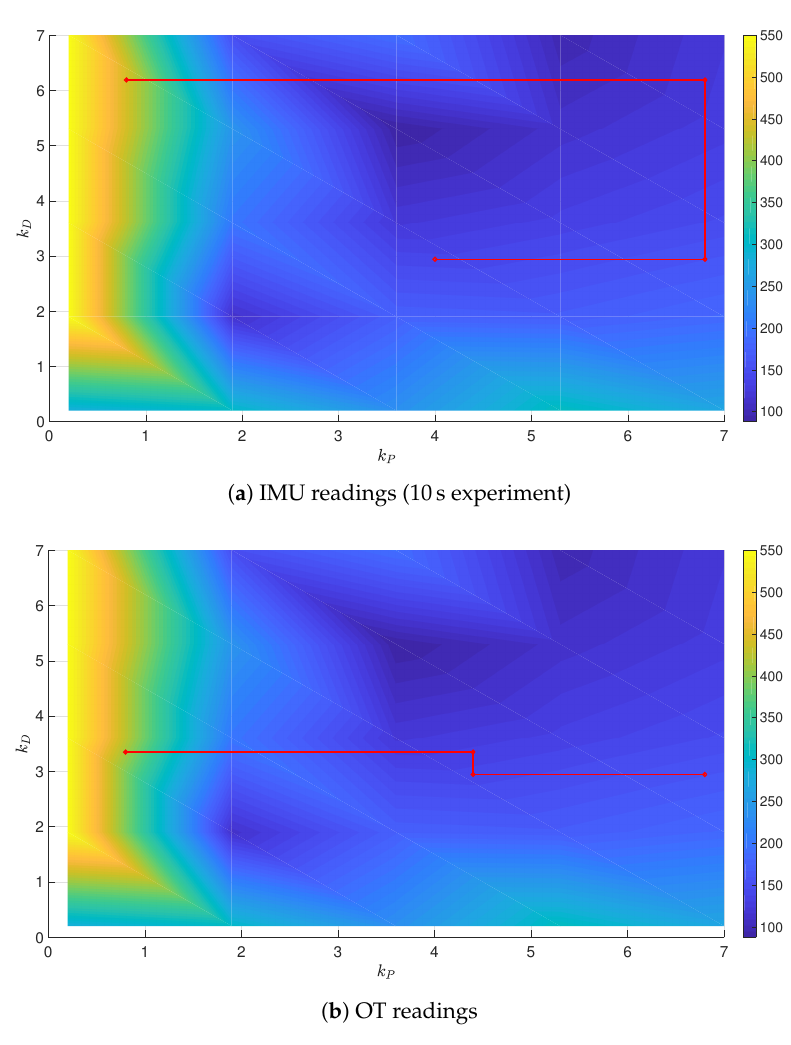
Figure 11. Minimum-energy trajectory surface with partial results of tuning.